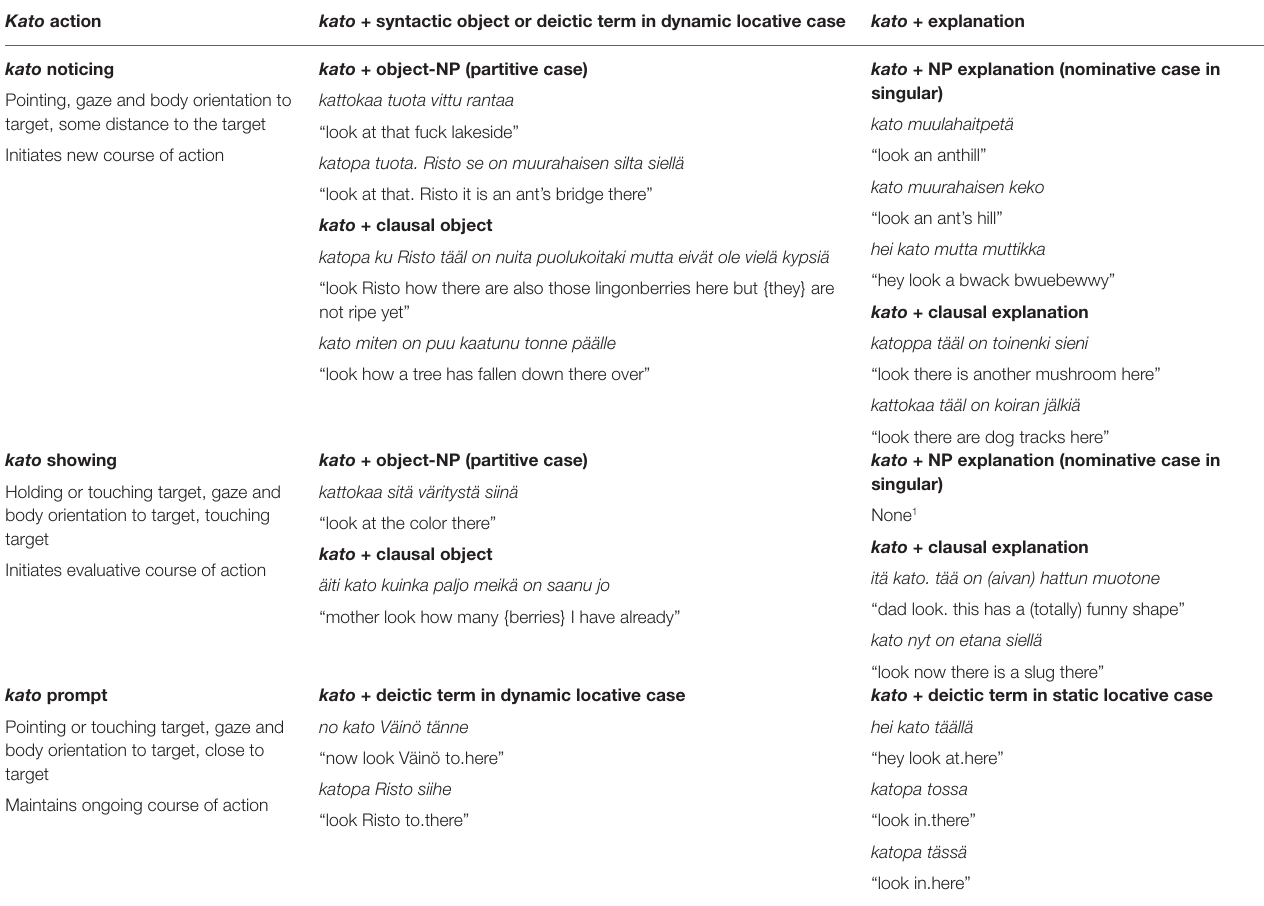
TABLE 2 | Examples of linguistic turn designs in kato noticings, showings, and